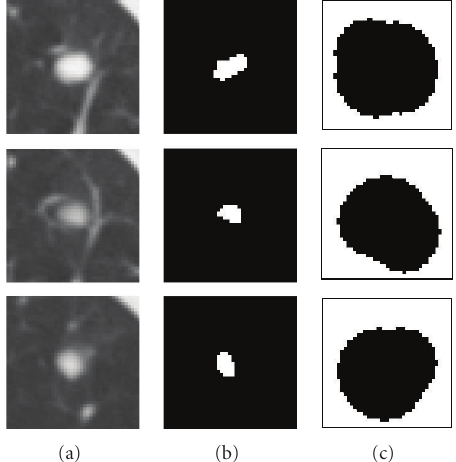
Figure 3: An example of the initialization based on spherical concentration on an attached nodule. (a) 3D nodule in three contiguous CT slices; (b) initial foreground based on high spherical concentration; (c) initial background region.